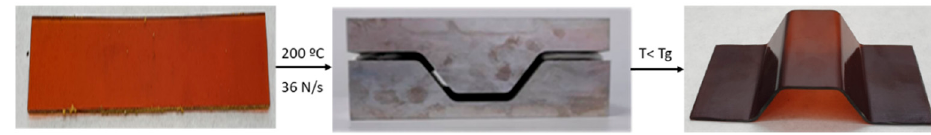
Figure 9. Validation of thermoforming capacity of aero grade epoxy vitrimer.